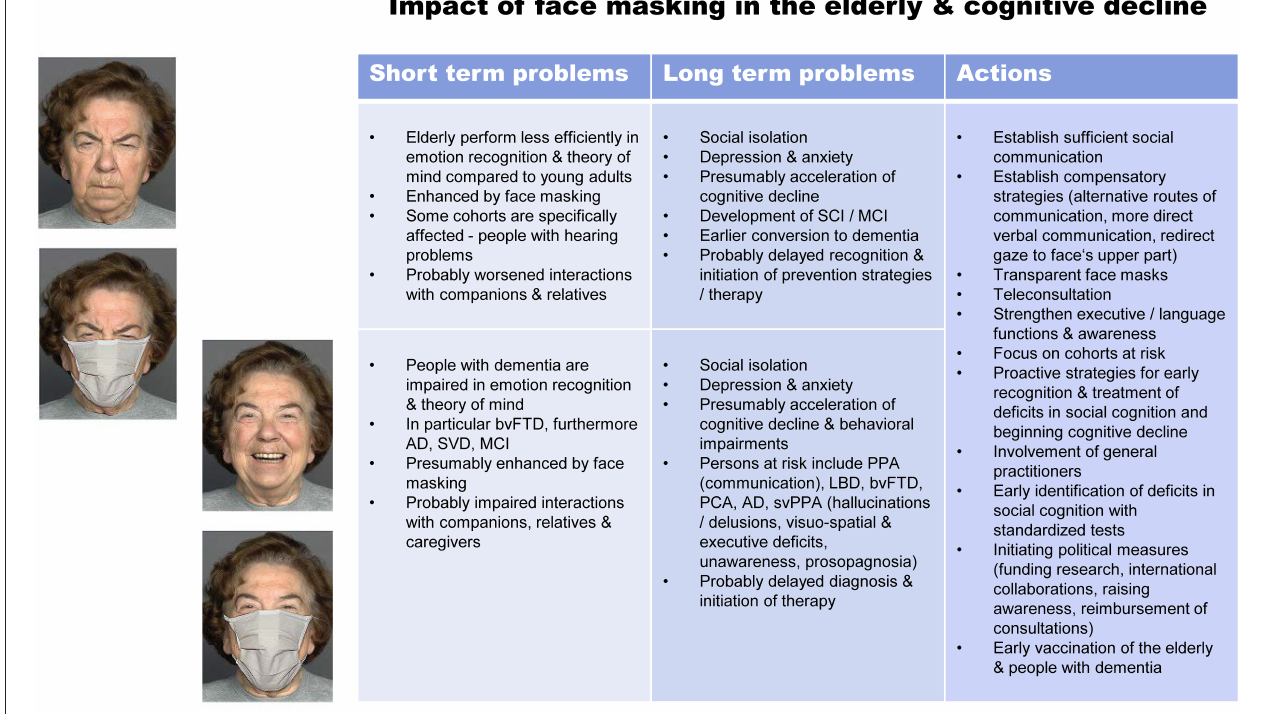
FIGURE 1 | Impact of face masking on social cognition in older adults (top) and people with dementia (bottom) and possible actions to encounter these problems. Photographs represent stimuli (angry and happy) from Carbon (2020). Further respective images can be found in the FACES database (Ebner et al., 2010; https:// faces.mpdl.mpg.de/imeji/). Carbon (2020) and Ebner et al. (2010) gave permission for publication of these images in the article. AD, Alzheimer’s dementia; bvFTD, behavioral variant frontotemporal dementia; LBD, Lewy body dementia; MCI, mild cognitive impairment; PCA, posterior cortical atrophy; PPA, primary progressive aphasia; SCI, subjective cognitive impairment; SVD, small vessel disease; svPPA semantic variant primary progressive